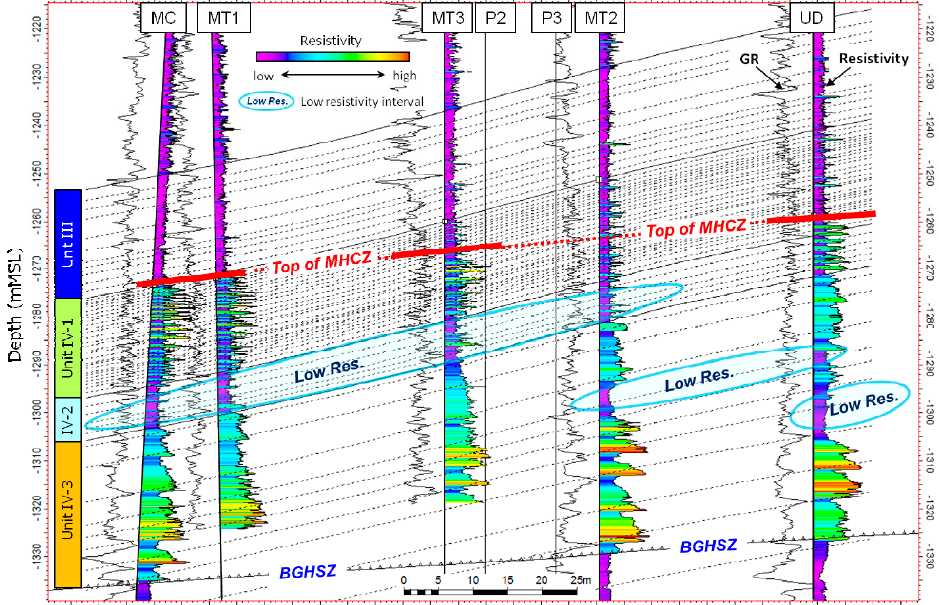
Figure 5. Logging data at AT1-UD, MT2, and MT3 wells, and the results of well-to-well correlations together with the existing wells (MC and MT1) at the first production test. Each well shows the log data of the gamma ray ( left ) and resistivity ( right ) measurements. Cross-section profiles pass through the MT2 well (Figure 4). The wells, except for the MT2 well, are plotted by the vertical projection to the cross-section. The geological unit boundary defined in this figure is in accordance with [16].